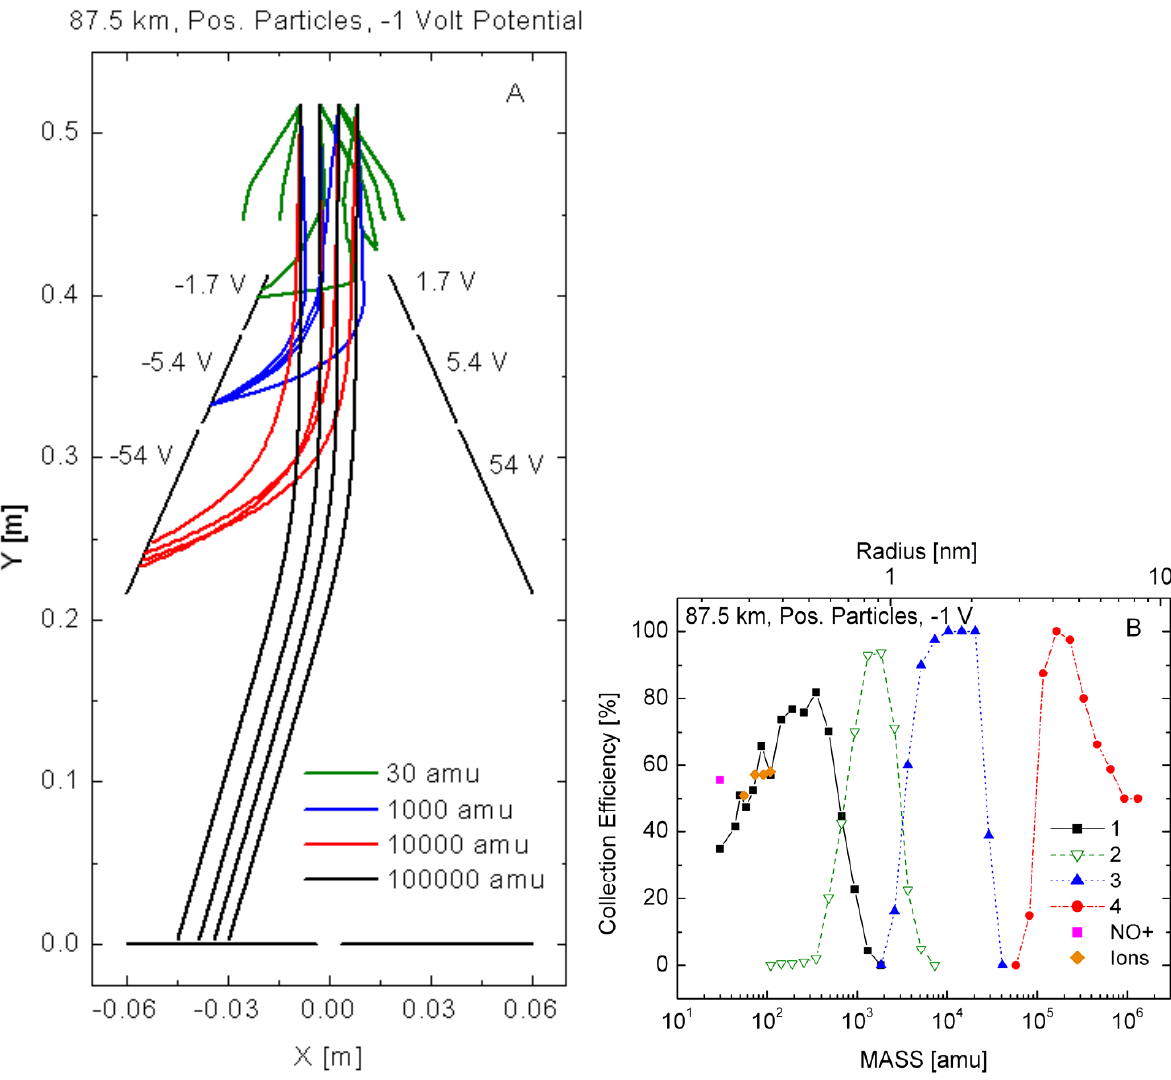
Fig. 2. (A) Plots of simulated trajectories of charged ice particles within the MASS instrument. At least 4 trajectories are plotted for each of the 4 particle masses. The trajectories are terminated if they hit an interior surface or if they leave the sampled air volume before entering the instrument. The assumed payload potential is − 1V. (B) Sensitivity curves from the numerical simulations that show the relative sensitivity of each channel as a function of mass at 87.5km. Particles with radii 2–3nm are deflected toward the air exit windows and thus do not fall on a collector plate, leaving a gap near 25000amu in the collected range of mass. The filled diamond symbols labeled “Ions” is for the proton hydrates with masses 55, 73, 91, and 109amu and the magenta square is for the NO +